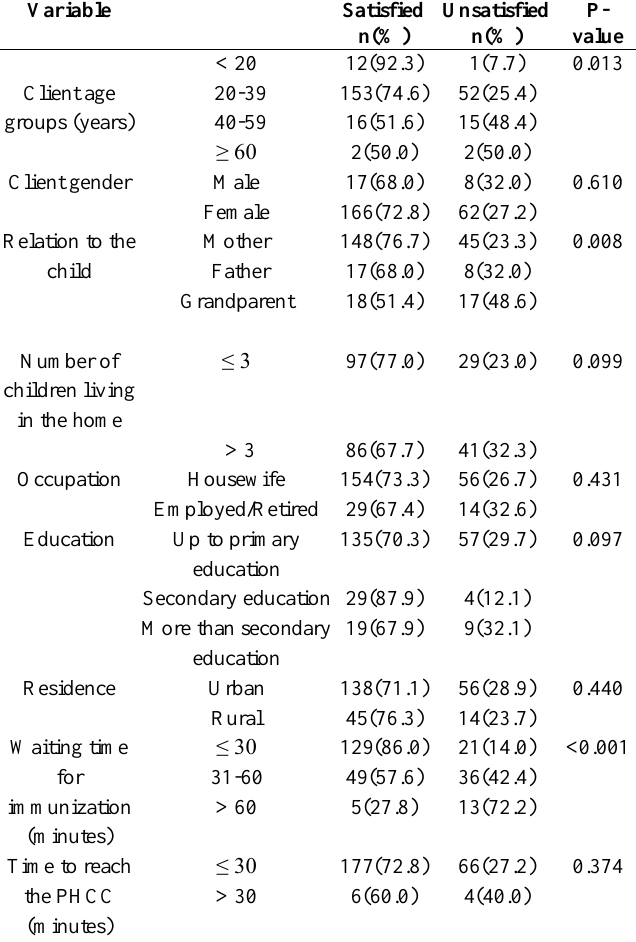
Association between client’s satisfaction to immunization services and their sociodemographic